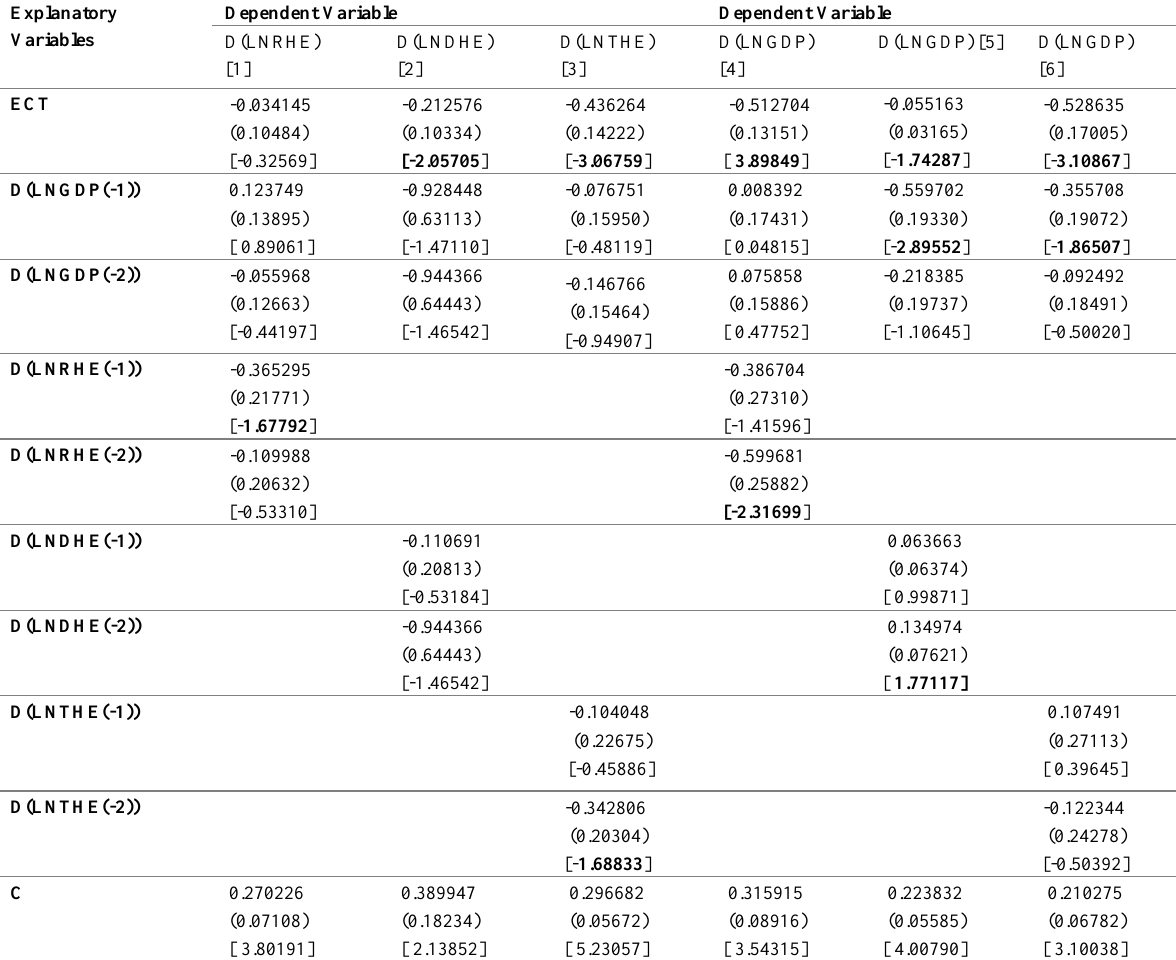
Table 3: Vector Error Correction Model